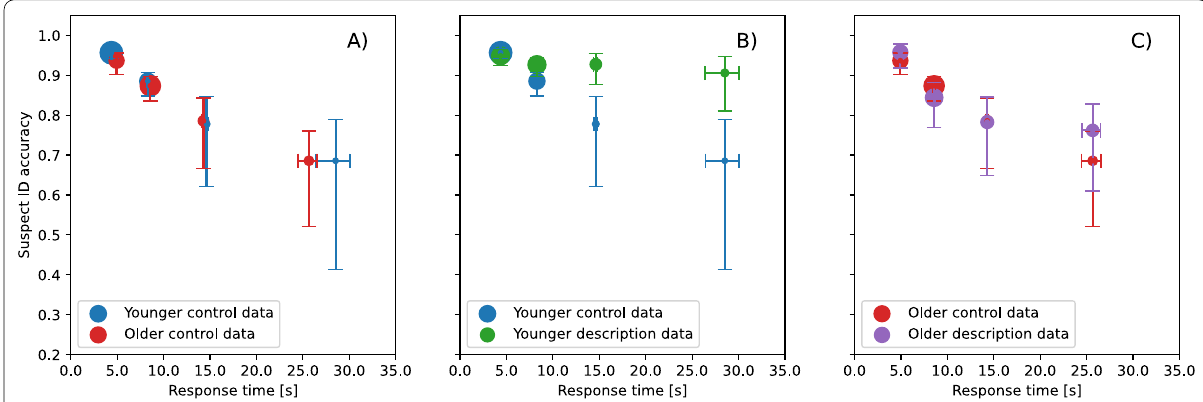
Fig. 3 RAC curves for response time bins: < 6 s, 6–12 s, 12–18 s, > 18 s for the A young and older group for the control condition, B control and experimental conditions for the young group, C control and experimental conditions for the older group. The error bars plot 68% bootstrap confidence intervals, which are the bootstrap equivalent of 1 standard ±